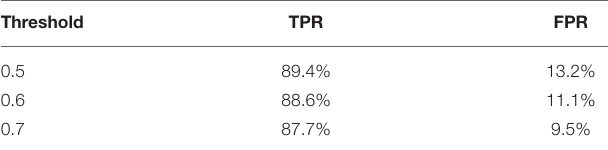
TABLE 3 | Video-level performance using ResNeXt-50 trained on datasets A, B, and A+B, no sliding window, alarm window = 5 seconds.